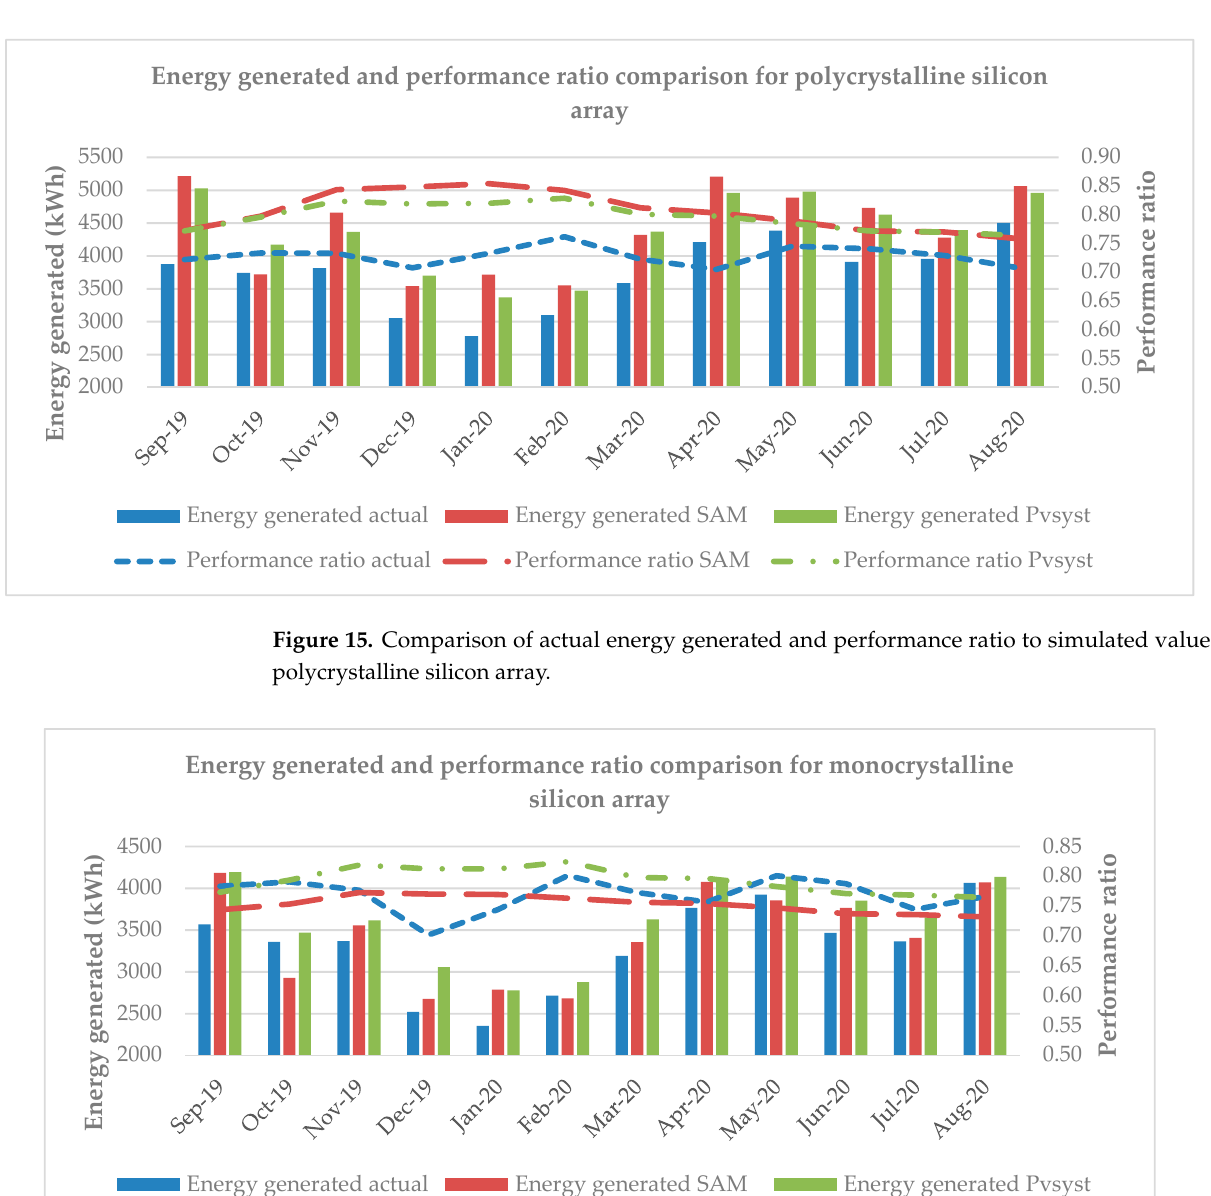
Figure 14. Sensitivity analysis of LCOE.